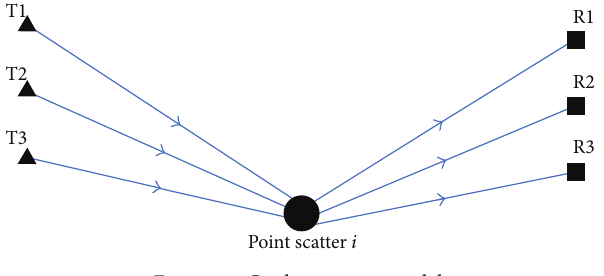
F 1: Circle scatterer